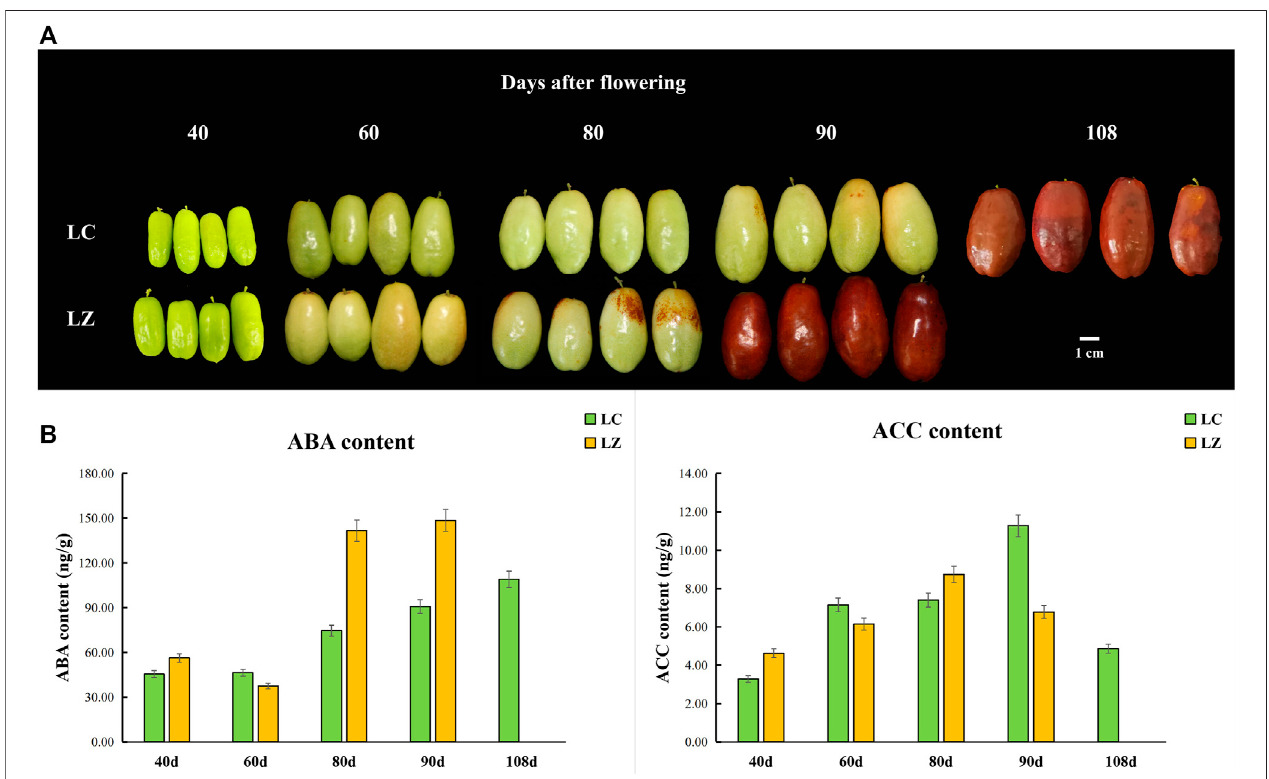
FIGURE 1 | Morphological characteristics and phytohormone trend at different fruit development stages (days after fl owering) from the ‘ Lingwu Changzao ’ jujube (LC) and its early ripening mutant (LZ). (A) Morphological characteristics of jujube fruit. (B) The contents of ABA and ACC.